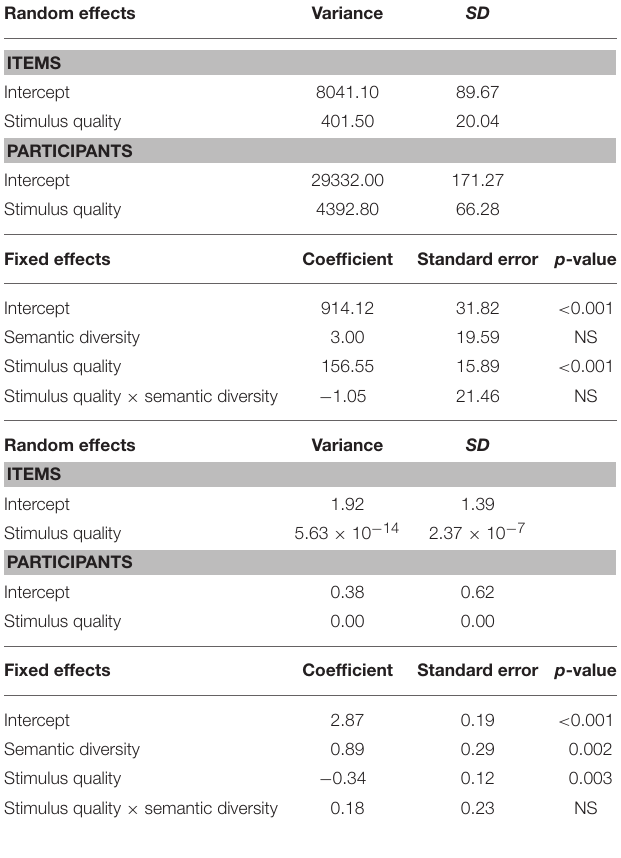
TABLE 8 | LME (top panel: RT) and GLM (bottom panel: Accuracy) model estimates for fixed and random effects for the joint effects of stimulus quality with semantic